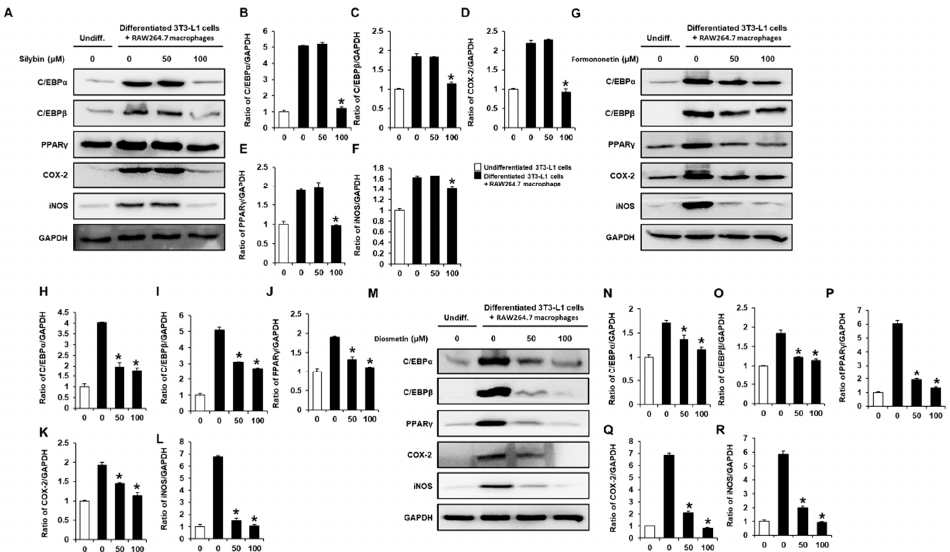
Figure 4. Inhibitory effects of silybin, formononetin, and diosmetin on the adipogenesis- and inflammation-associated proteins in co-cultures of 3T3-L1 and RAW264.7 cells. ( A – F ) Protein expression levels and ratios of band intensities of CCAAT/enhancer-binding protein alpha (C/EBP α ), C/EBP β , peroxisome proliferator-activated receptor γ (PPAR γ ), cyclooxygenase-2 (COX-2), and inducible nitric oxide synthase (iNOS) in co-cultures of 3T3-L1 and RAW264.7 cells treated with the indicated concentration of silybin. ( G – L ) Protein expression levels and ratios of band intensities of C/EBP α , C/EBP β , PPAR γ , COX-2, and iNOS in co-cultures of 3T3-L1 and RAW264.7 cells treated with the indicated concentration of formononetin. ( M – R ) Protein expression levels and ratios of band intensities of C/EBP α , C/EBP β , PPAR γ , COX-2, and iNOS in co-cultures of 3T3-L1 and RAW264.7 cells treated with the indicated concentration of diosmetin. Undiff, undifferentiated 3T3-L1 cells. In individual experiments, each treatment condition was set up in quadruplicate, and each experiment was repeated 3 times independently (* p < 0.05 compared to untreated cells, Kruskal–Wallis non-parametric test). Data are represented as the mean ± SEM.